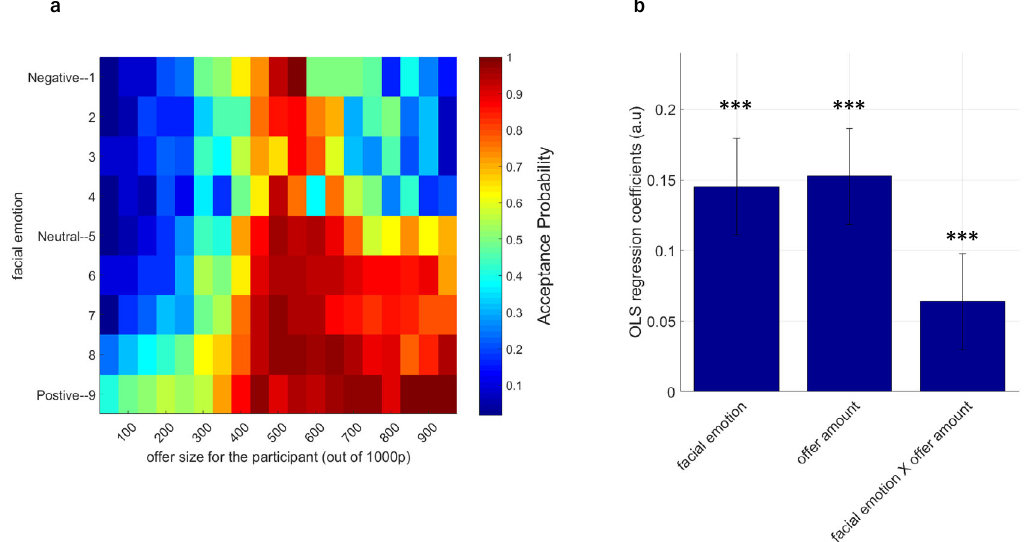
Fig. 3 Behavioural results from the Ultimatum Game. a Participants ’ average acceptance probabilities across all possible combinations of proposer ’ s facial emotion (y-axis) and offer amounts (x-axis) represented as a heat map. The data shown in the heat map is concatenated across all participants and all conditions. Colour bar shows the probability of accepting an offer. Changes in the colour gradient in the heat map suggest that unfair offers coming from positive faces were more likely to be accepted relative to offers associated with negative facial emotions, even if the negative-emotion offer amount is advantageous to the participant. b A formal OLS regression analysis conducted on the acceptance probabilities indicated a signi fi cant main effect of facial emotion, a main effect of offer amount and a signi fi cant facial emotion by offer amount interaction term in fl uencing participants ’ probability of accepting an offer (*** p < 0.001). Error bars denote ±1 SEM.